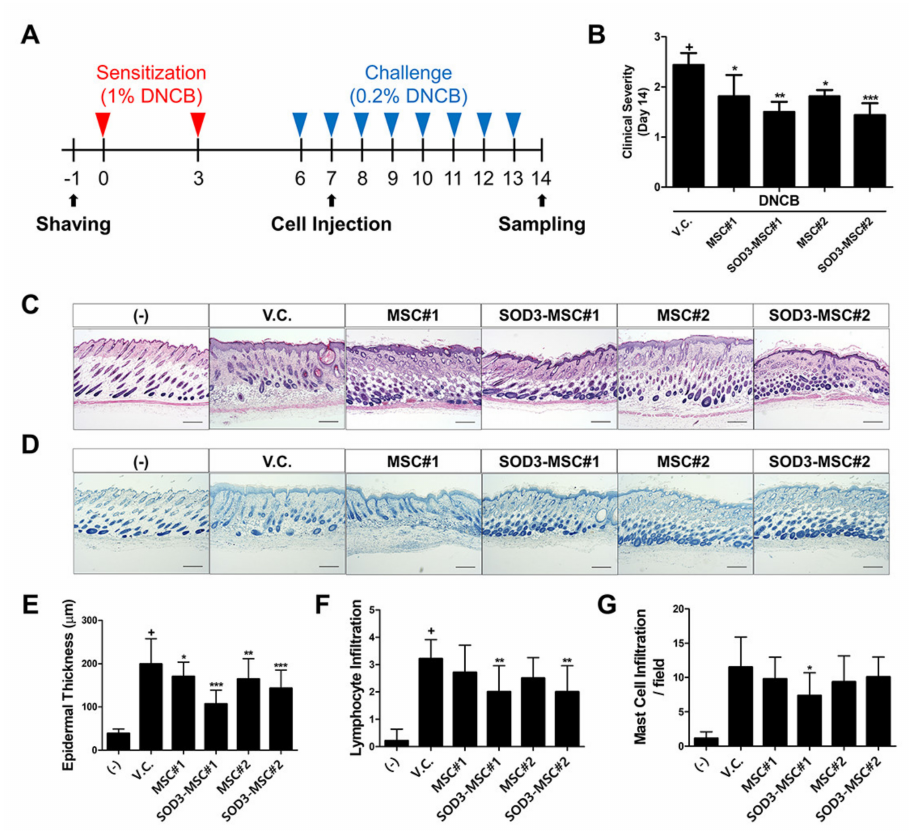
Figure 5. In vivo anti-inflammatory e ff ects of MSCs. ( A ) 2, 4-dinitro chlorobenzene (DNCB) was used to induce atopic dermatitis (AD) in BALB / c mice. MSCs or SOD3-MSCs were injected subcutaneously, near the lesion site on day 7. ( B ) On day 14, the clinical severity of mice was scored. V.C.; vehicle control. ( C ) Skin tissues of mice were harvested after sacrifice and were subjected to hematoxylin and eosin (H&E) staining. Scale bar = 100 µ m. ( D ) Toluidine blue staining was performed to determine the number of mast cells. Scale bar = 100 µ m. ( E ) Epidermal thickness was measured. ( F , G ) The number of infiltrated lymphocytes ( F ) and mast cells ( G ) was counted. Results are shown as mean ± SD. *, **, and *** represent p < 0.05, p < 0.01, and p < 0.001, respectively. p -value significance was calculated by comparing other groups against the ( + ) group (marked as +